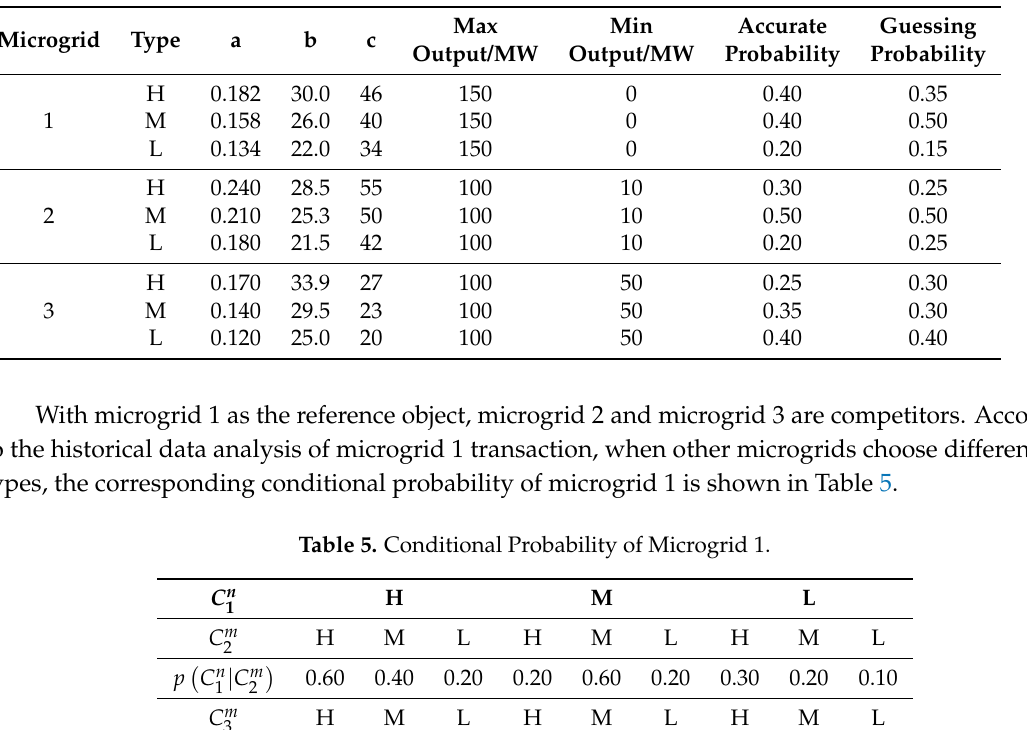
Table 4. Hypothetical Parameters of Microgrids.